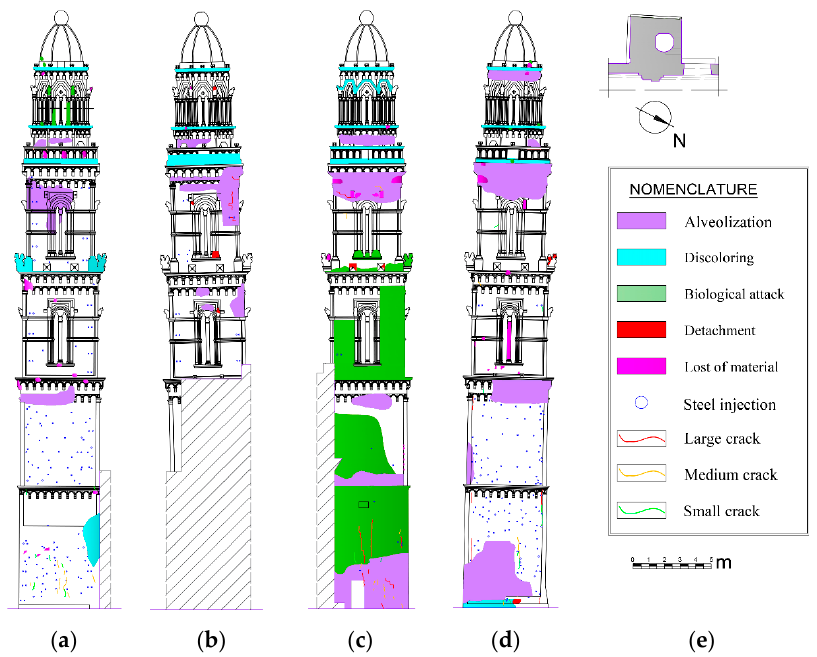
Figure 7. Status of the bell-tower: ( a ) South, ( b ) East, ( c ) North, ( d ) West and ( e ) plan view.